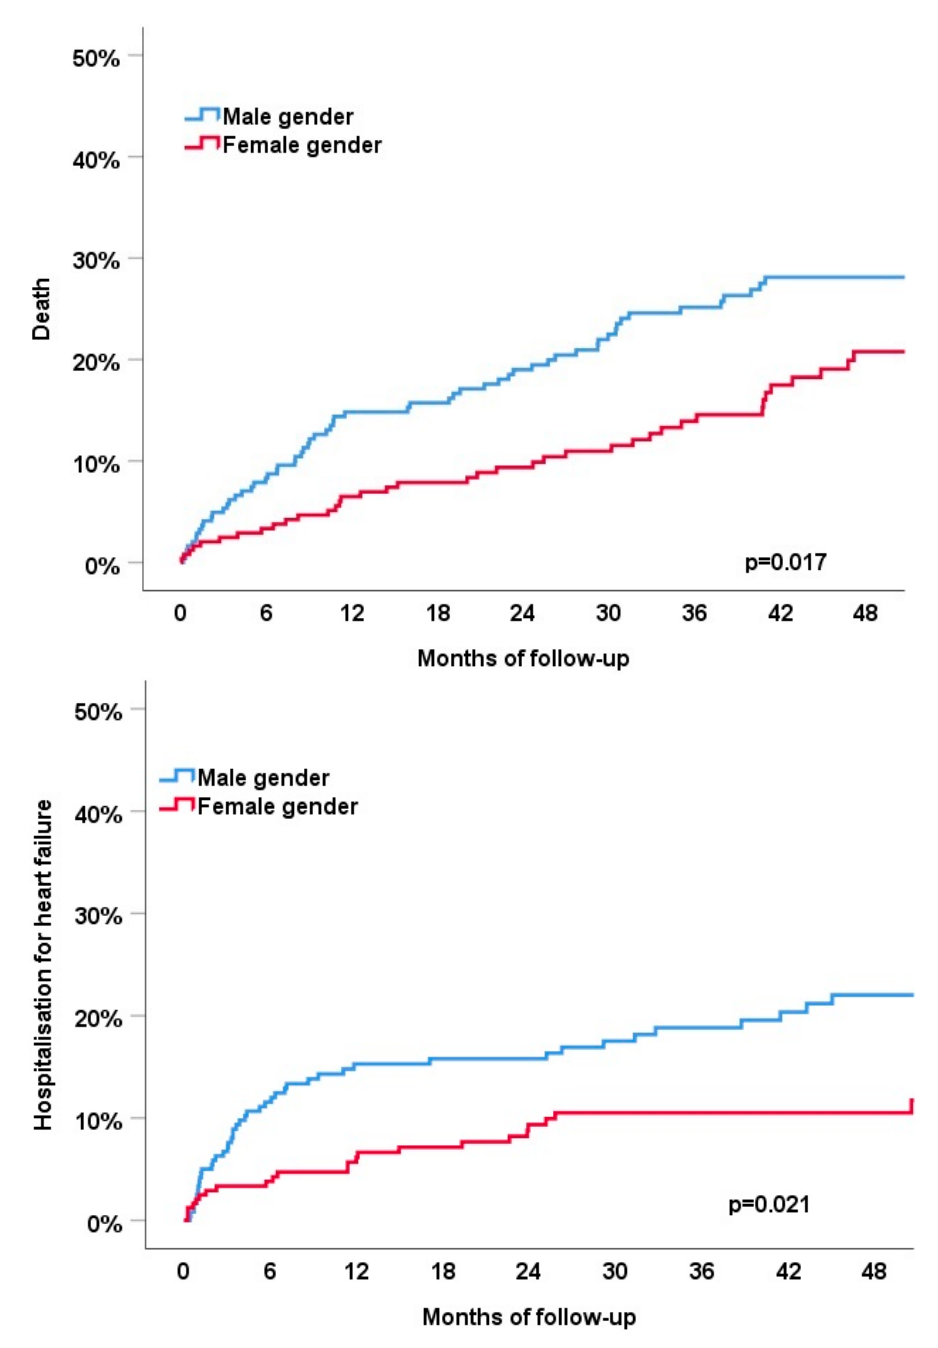
Figure 2. Association of sex category with the all-cause death ( top ) and heart failure hospitalization ( bottom ) during 4 years of follow-up. ( bottom ) during 4 years of